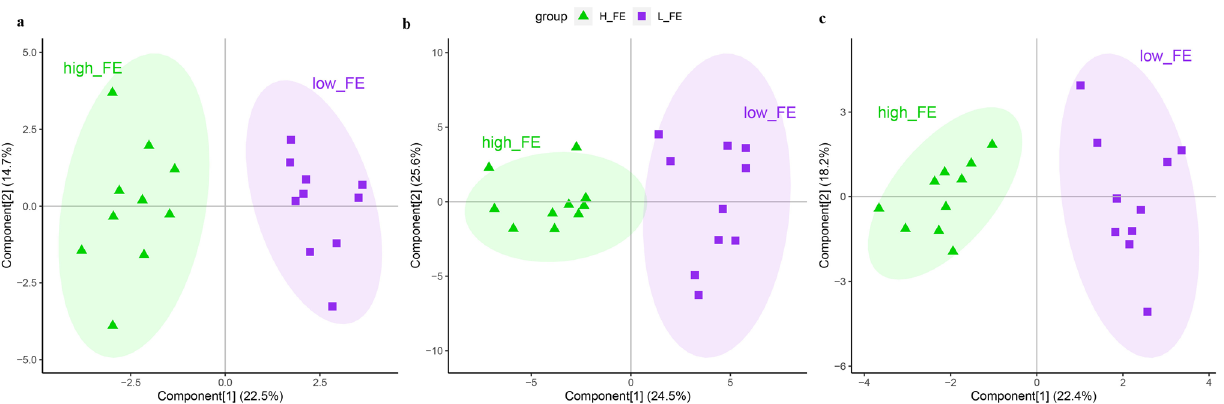
Figure 3. The OPLS-DA models discriminated between the HFE and LFE groups (R2Y of 0.93, 0.86 and 0.91 and Q2 of 0.73, 0.58 and 0.76 in ileum, cecum and colon, respectively). Permutation test (200 permutations) yielded pR2 < 0.05, pQ2 < 0.05 in each location ( a ileum, b cecum, c